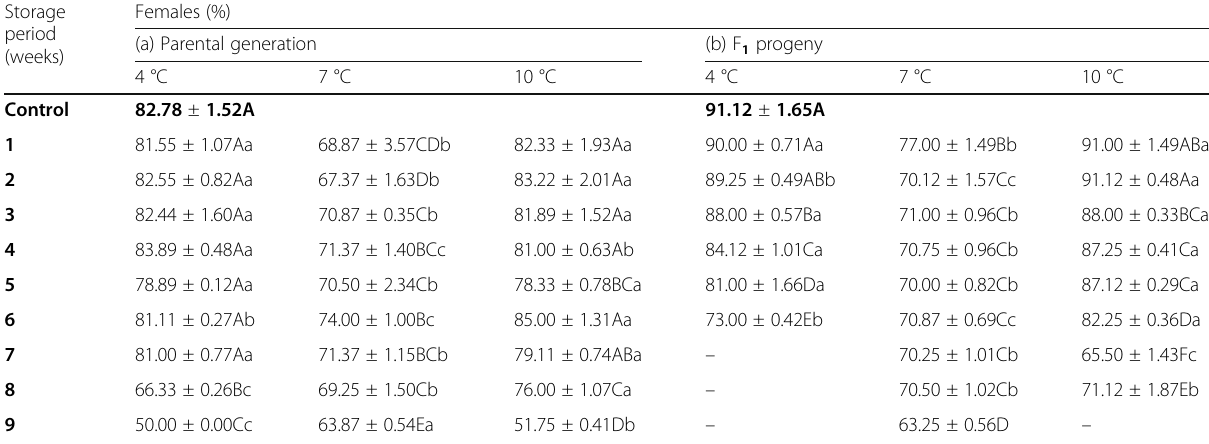
Table 7 Percentages of Trichogrammatoidea bactrae females in parental and F 1 generations during storage of parasitoid pre-pupae at different low temperatures Storage period